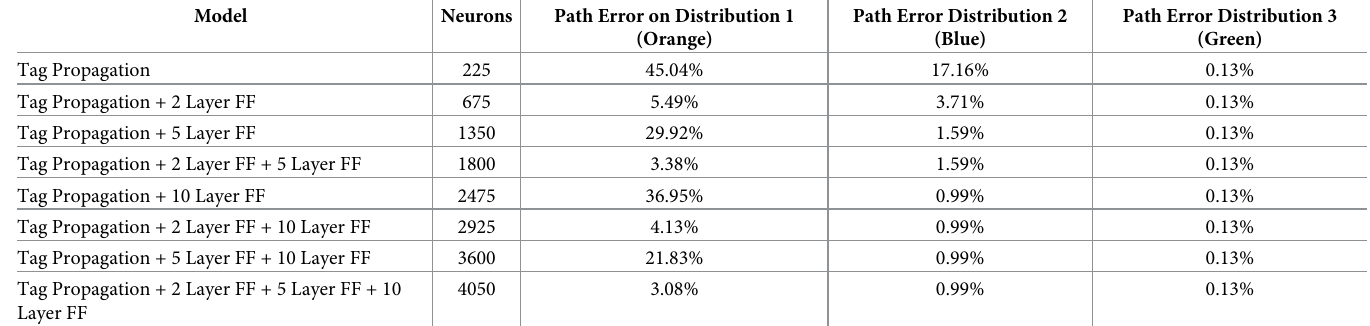
Table 3. Hybrid Model Performance. Hybrid models considered in Fig 4C . Models were only included in the plot if adding neurons decreased the loss. The models were assumed to be given the allowed computational time at initialization, enabling them to switch